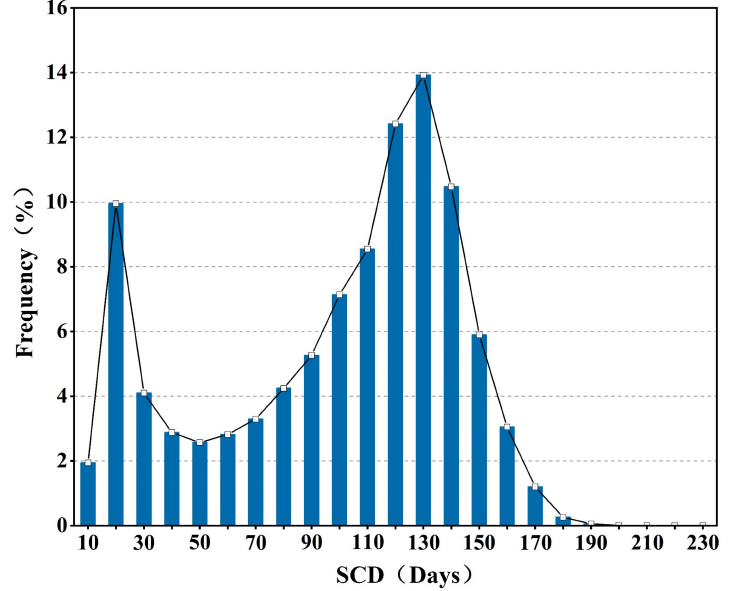
Figure 4. Histogram of annual average SCD from HY2001 to HY2017 in Northeast China. Figure 5a indicates that the SCD in Northeast China mainly increased, accounting for 62.27% of the total, among which only 4.73% increased significantly. The regions where the SCD increased were mainly in the southern Daxingan Mountains, Xiaoxingan Mountains and Changbai Mountains. SCD decreased mainly in the northern Daxingan Mountains and the southwestern Changbai Mountains, accounting for 20.25% of the total area, and only 0.24% of the total area recorded significant decreases. Figure 5b showed the area with